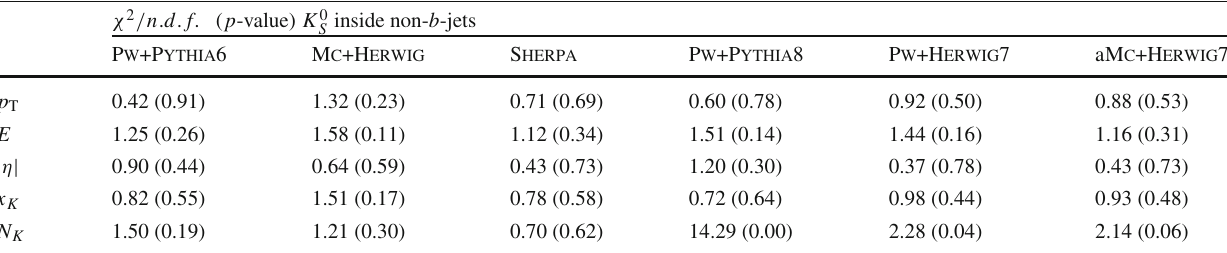
Table 8 Values of the χ 2 per degree of freedom and their corresponding p -values, for K 0 MC@NLO + Herwig , Sherpa , Powheg + Pythia8 , Powheg + Herwig7 and a MC@NLO + Herwig7 predictions